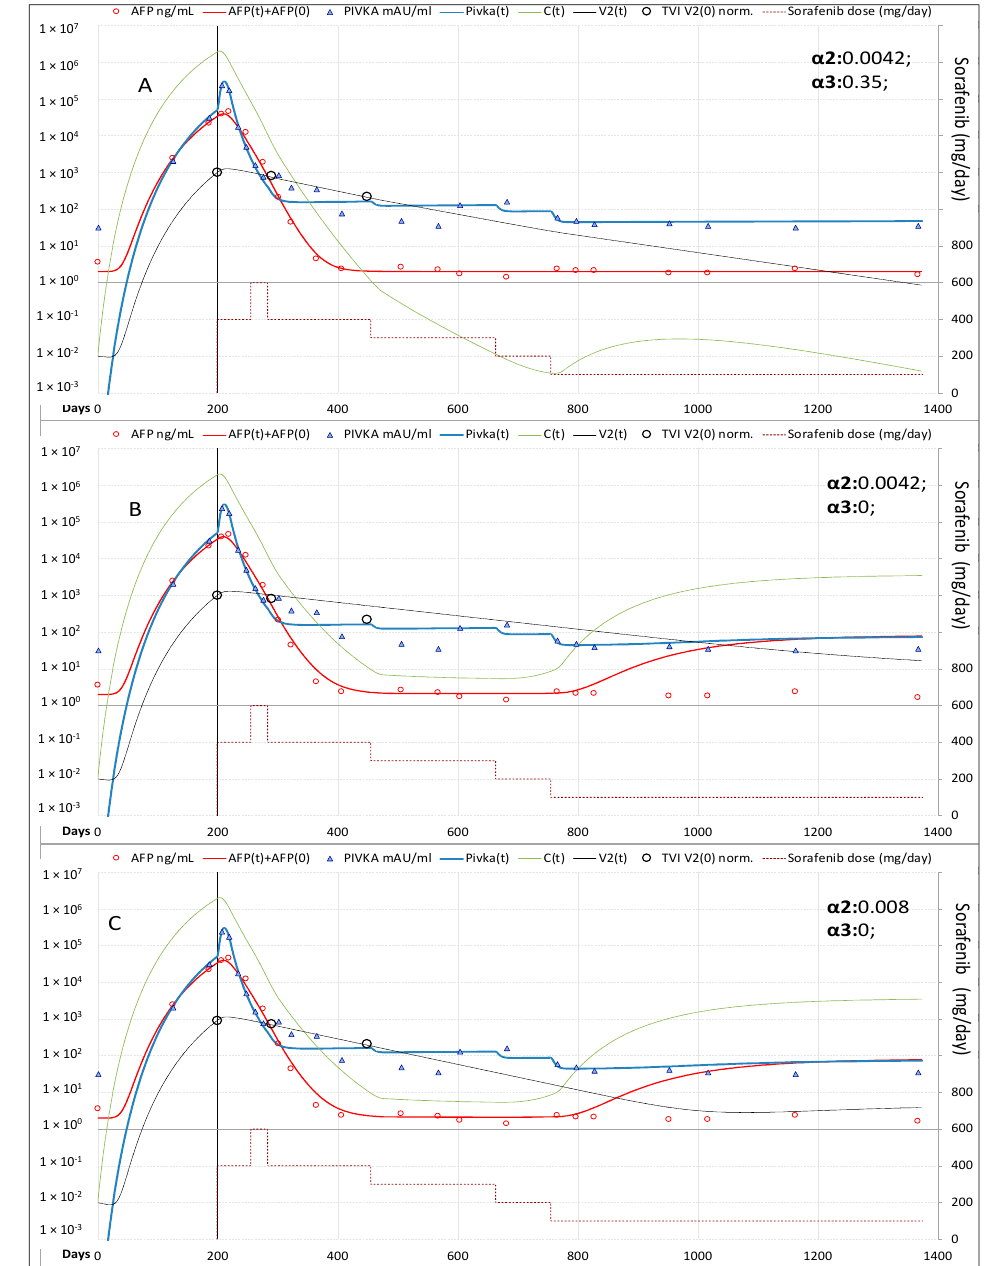
Figure 2. Model fitting of measured variables in Case-1. ( A ) Best fitting of Tumor Vascular Index (TVI), AFP and PIVKA-II serum levels. ( B ) In absence of the additional dose dependent decay constant of tumor vasculature, the model predicts recurrence of HCC when sorafenib dose is reduced to 200 mg every other day. ( C ) Halving the mean lifetime of tumor vascularization the model still predicts tumor recurrence. Legend : AFP = measured AFP; AFP(t) = model computed AFP; AFP(0) = AFP normal value; PIVKA-II = measured PIVKA-II; Pivka(t) = computed PIVKA-II; C(t) = model computed cancer cells; V2(t) = model computed vascularization index; TVI V2(0) norm = CT measured tumor vascular index normalized to V2 at treatment baseline.